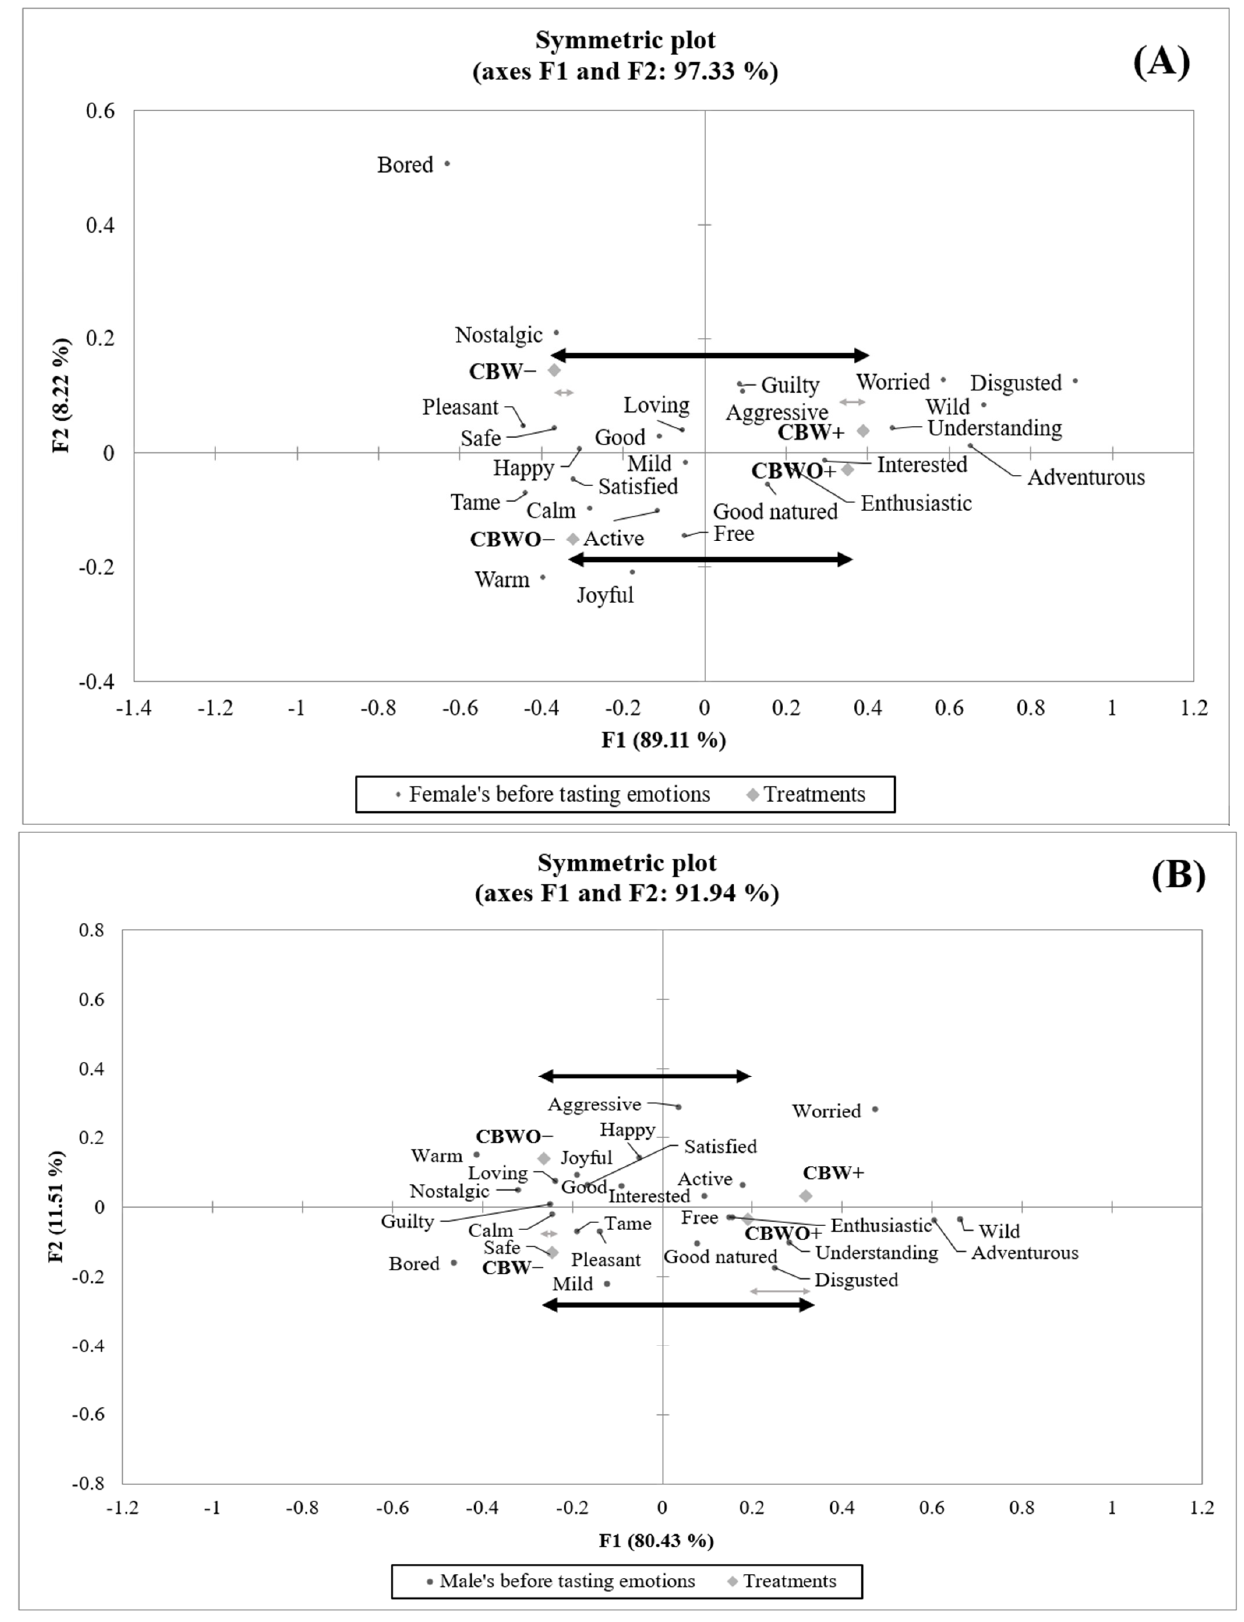
Figure 3. Correspondence analysis (chi-squared distance) symmetric plot visualizing treatments † and emotions in the before-tasting condition from ( A ) female ( n = 112) and ( B ) male ( n = 98) groups. † Treatments are described in Figure 1.